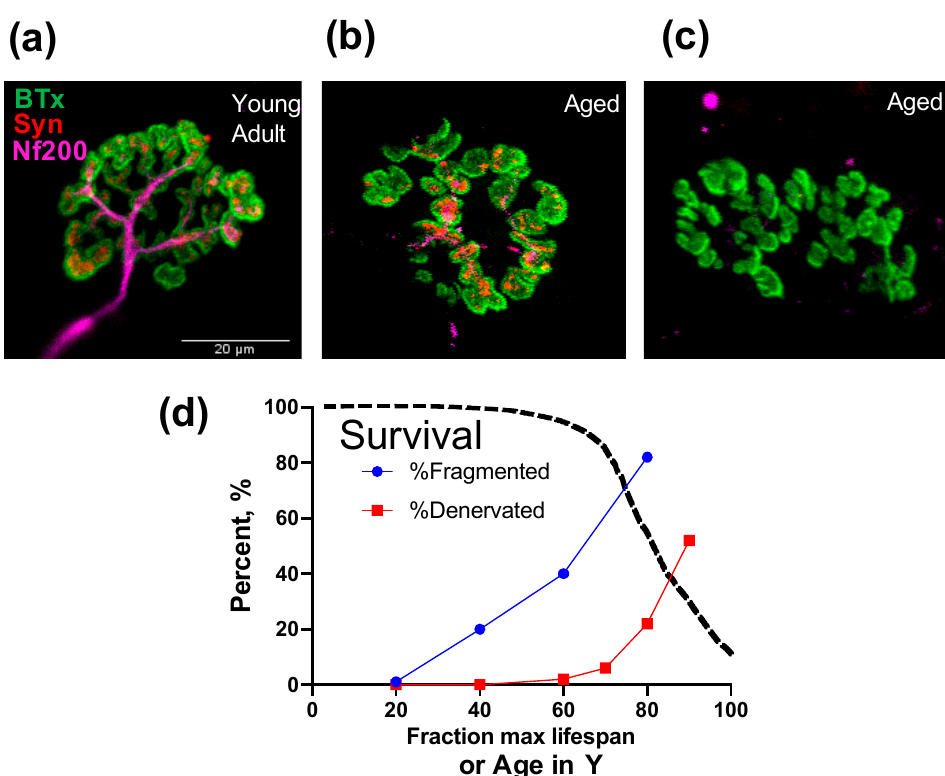
Figure 1. Impact of aging on the neuromuscular junction. Immunofluorescently labeled images of the neuromuscular junction from Young Adult ( a ) and Aged ( b , c ) Fisher 344 x Brown Norway rat gastrocnemius muscle reveal fragmentation of the post-synaptic AChR clusters ( b ) and some endplates that completely lack detectable motoneuron terminals ( c ). BTx = α -bungarotoxin to label the post-synaptic AChRs; Syn = synaptophysin to label the motoneuron terminals; Nf200 = neurofilament 200 to label the motoneuron axons. Panel ( d ) is based upon composite information about neuromuscular junction fragmentation and denervation from mouse [19], and muscle fiber denervation from rat [7] and human [14] skeletal muscle, to depict the time-course of neuromuscular junction fragmentation (blue line) and muscle fiber denervation (red line) relative to maximal lifespan and species-specific survival characteristics (dashed line).